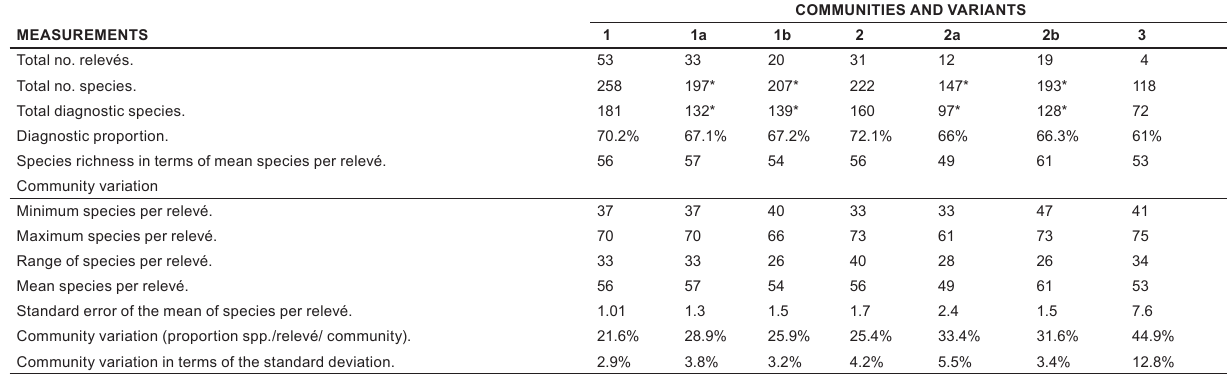
table 2 Community and variant statistics for the Andover Game Reserve